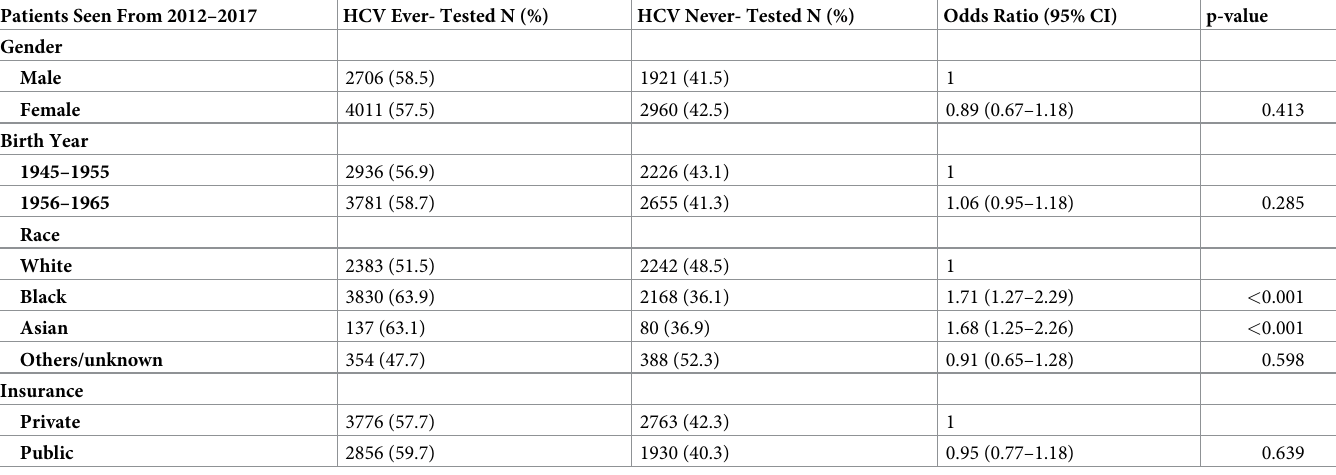
Table 2. Multivariate logistic regression for ever receiving HCV screening, clustered by clinic.